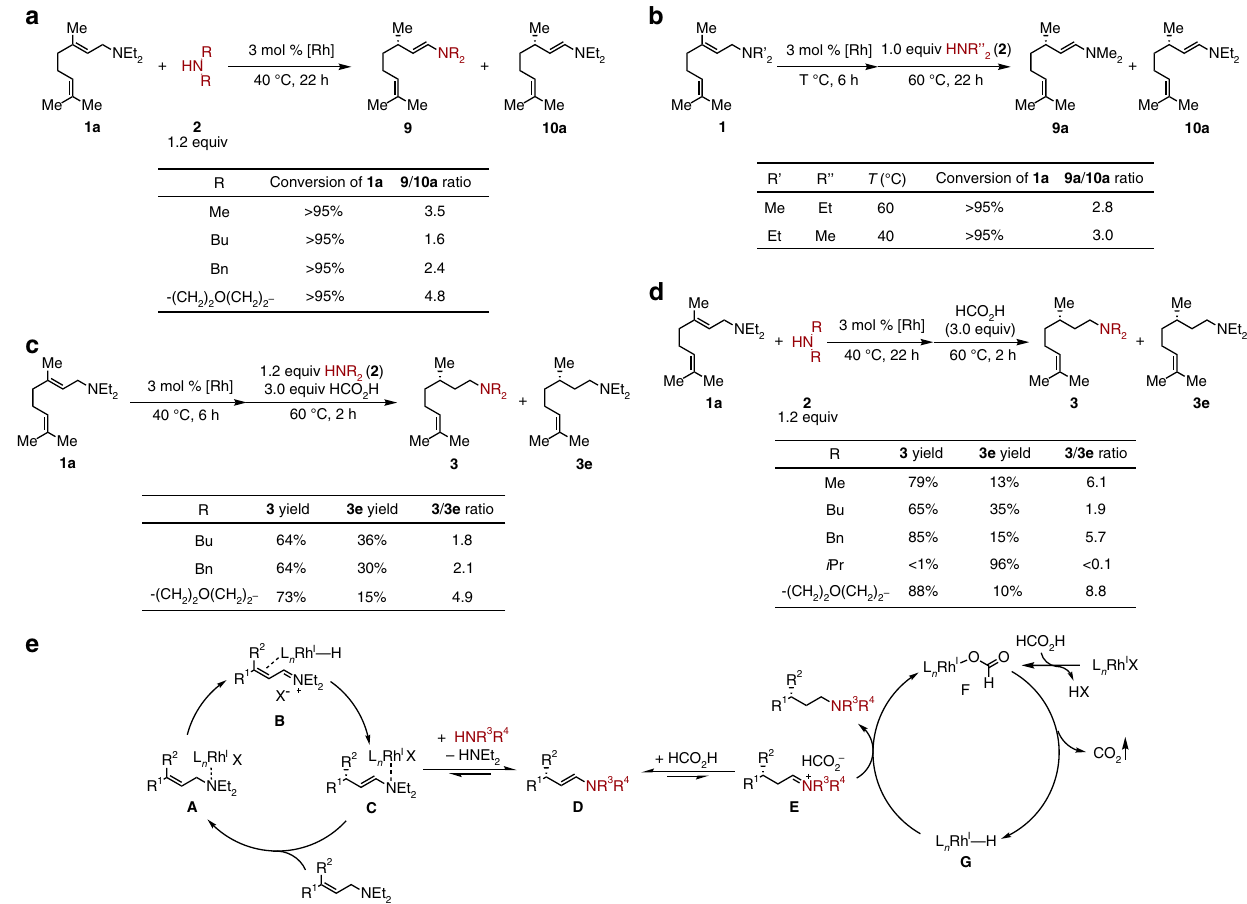
Fig. 6 Control experiments and proposed catalytic cycles. a Selectivity of the enamine exchange step. b Thermodynamic equilibrium for the enamine exchange. c Selectivity of the transfer hydrogenation step (simultaneous addition of amine and hydrogen donor). d Chemoselectivity for various secondary amine nucleophiles under standard conditions. e Proposed catalytic cycles: enantioselective isomerization and transfer hydrogenation, X = BAr 4